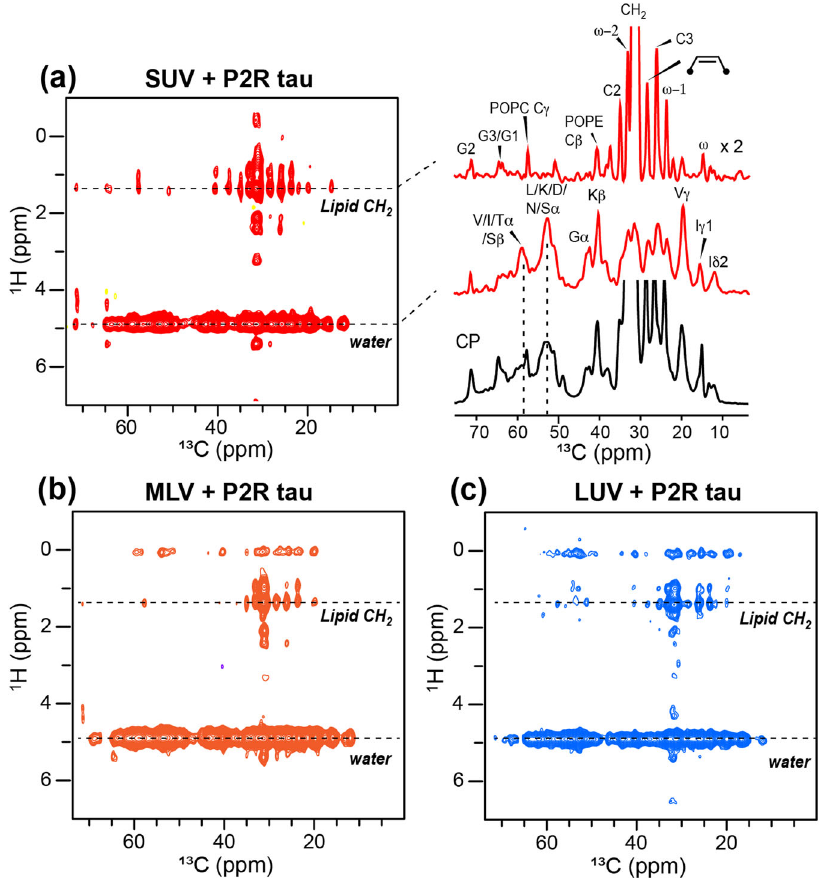
Fig. 5 2D 1 H- 13 C HETCOR spectra indicate that tau does not insert into lipid membranes under the current experimental conditions. a 2D 1 H- 13 C HETCOR spectrum of SUV-bound P2R tau. 13 C cross sections at the lipid CH 2 and water 1 H chemical shifts are shown on the right. Key protein and lipid 13 C signals are assigned. No protein 13 C to lipid acyl chain 1 H correlations are observed, indicating that tau does not insert into the hydrophobic interior of the membrane. b 2D 1 H- 13 C HETCOR spectrum of MLV-bound P2R tau. c 2D 1 H- 13 C HETCOR spectrum of LUV-bound P2R tau. No protein-lipid cross peaks are observed in any of these membranes. The three spectra were measured using a 1 H mixing time of 100 ms after a 1 H T 2 fi lter of 2 × 2.18 ms to remove the rigid protein